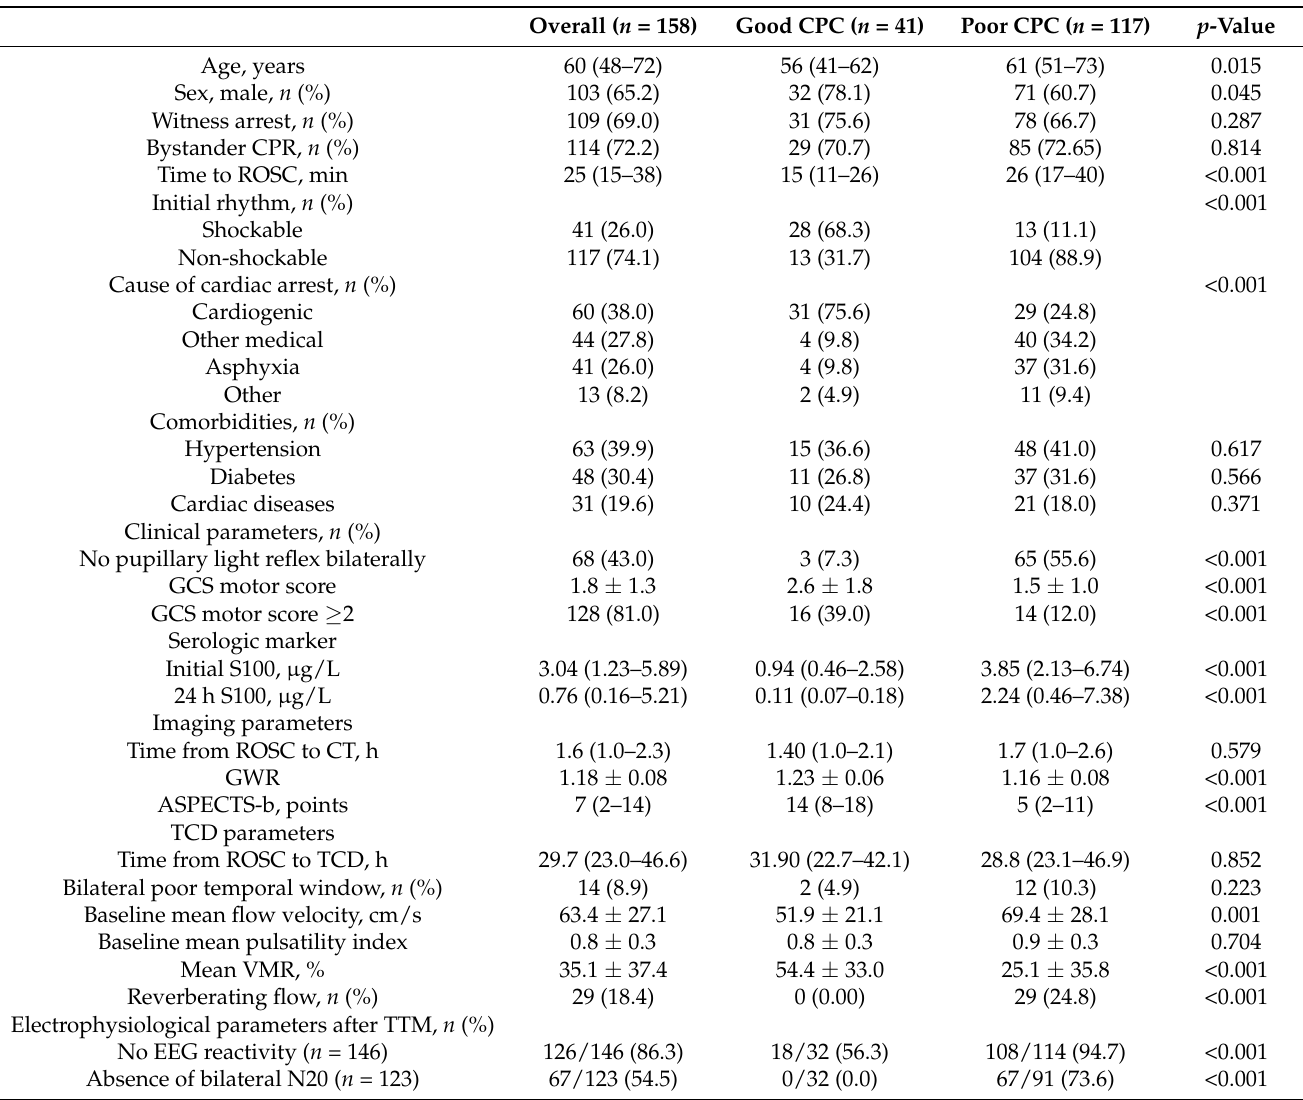
Table 1. Baseline characteristics and prognostic parameter according to